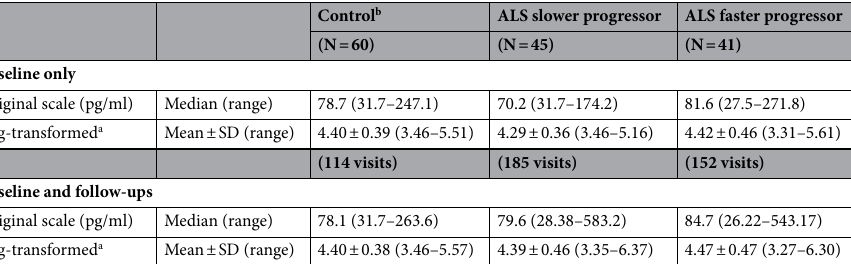
Table 3. Plasma FGF23 concentration. Baseline = first visit at which plasma sample was available. N = number of participants. Visits = number of person-visits. a Natural algorithm. b N = 1 control whose FGF23 values were extreme outliers (773.5 and 988.3 pg/ml at baseline and follow-up, respectively) was excluded from table